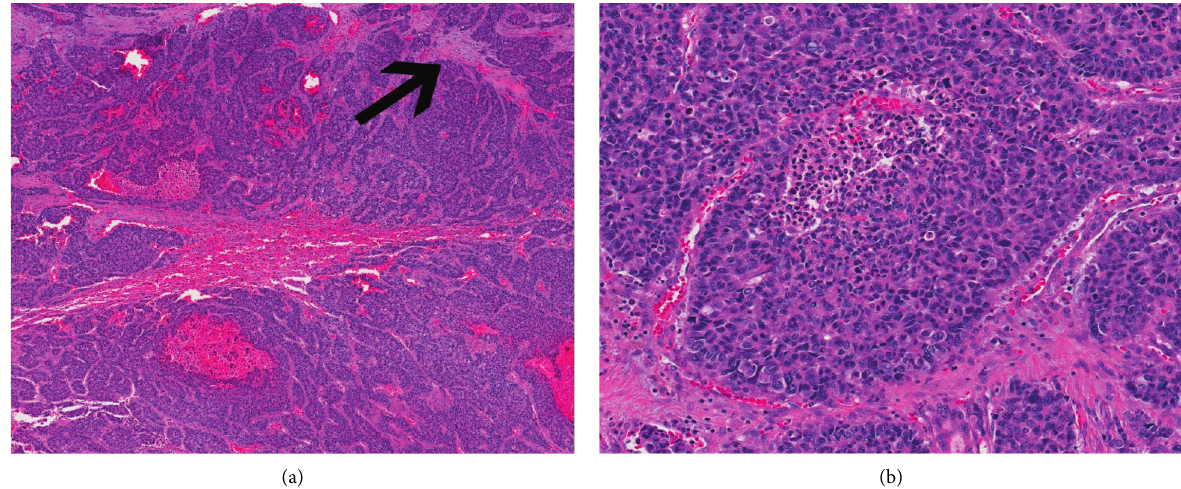
Figure 2: The tumour composed of variably sized nests and trabeculae associated with desmoplasia (arrow) and hemorrhage. (a) High-grade tumour cells containing enlarged, hyperchromatic nuclei with relatively scant cytoplasm extensive necrosis. (b) The high-grade areas are positive for cytokeratin-7 and show patchy staining for arginase and Hepar-1.